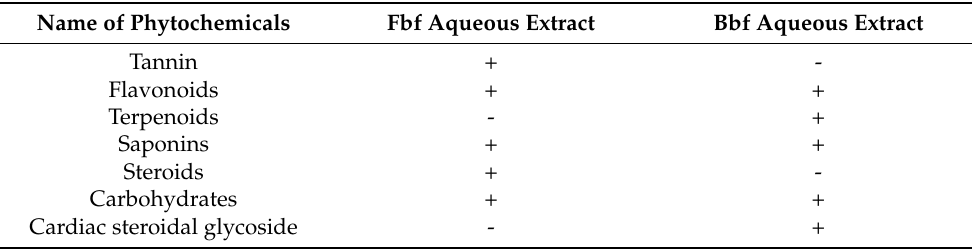
Table 1. Preliminary phytochemical screening of Fbf and Bbf aqueous